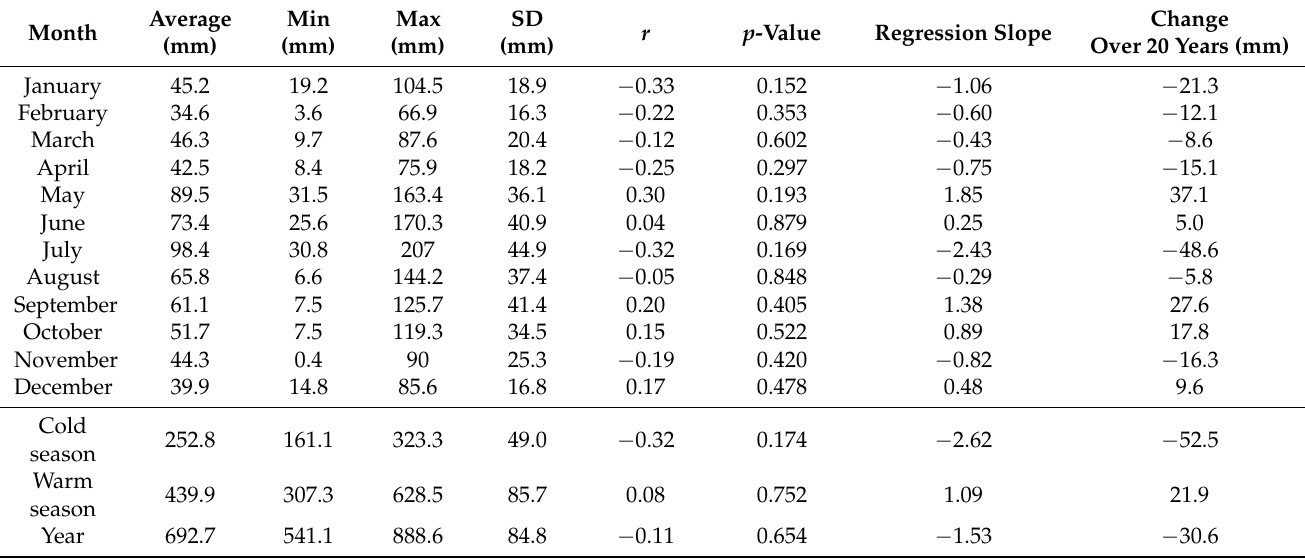
Table 1. Average precipitation trend for the years 2001–2020. Data compiled by the authors from the Reports of the “Roztocze” Base Station of the Integrated Monitoring of Natural Environment.